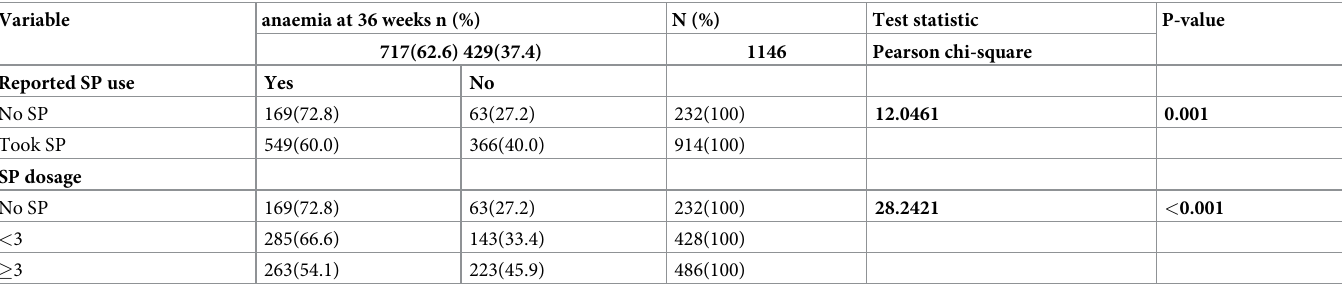
Table 2. Prevalence of anaemia in relation to IPTp doses